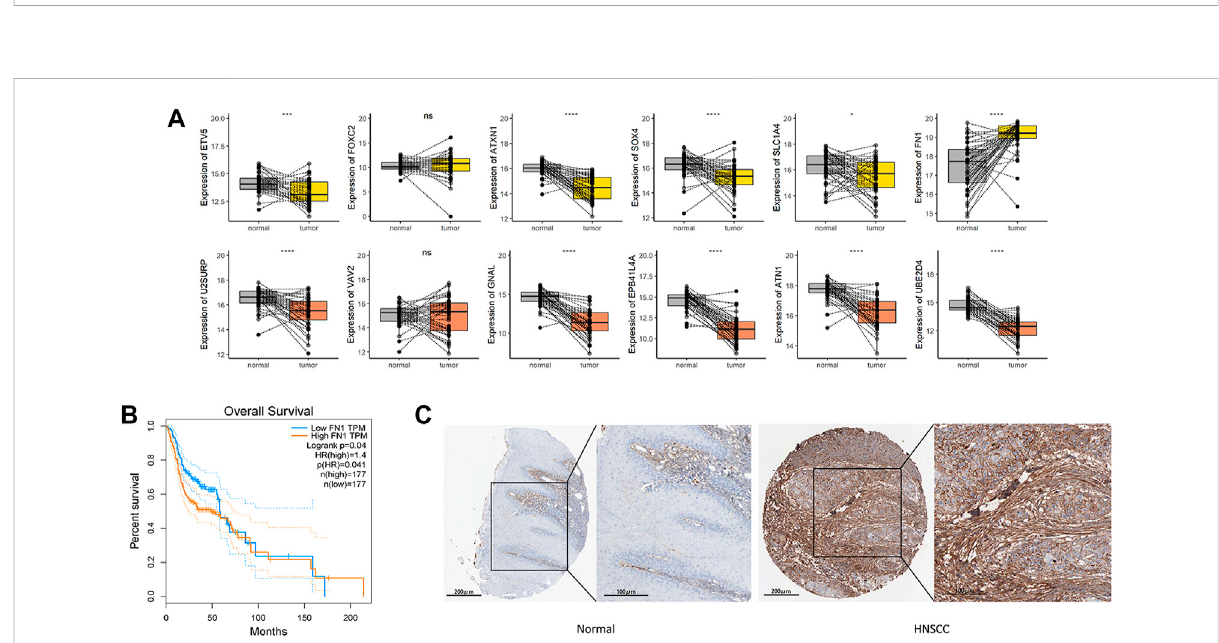
FIGURE 5 (A) InHNSCCTCGAdataset,overexpressionofFN1,SOX4andETV5werefoundin43pairedsamplesbetweenparacanceroustissuesandtumor tissues. (B) WhileonlyFN1wasassociatedwithprognosiswhenallHNSCCsamplesinTCGAdatasetwereincluded. (C) FN1overexpressedinHNSCC tissues, meaning protein expression was consistent with mRNA expression. *** p < 0.001, **** p <